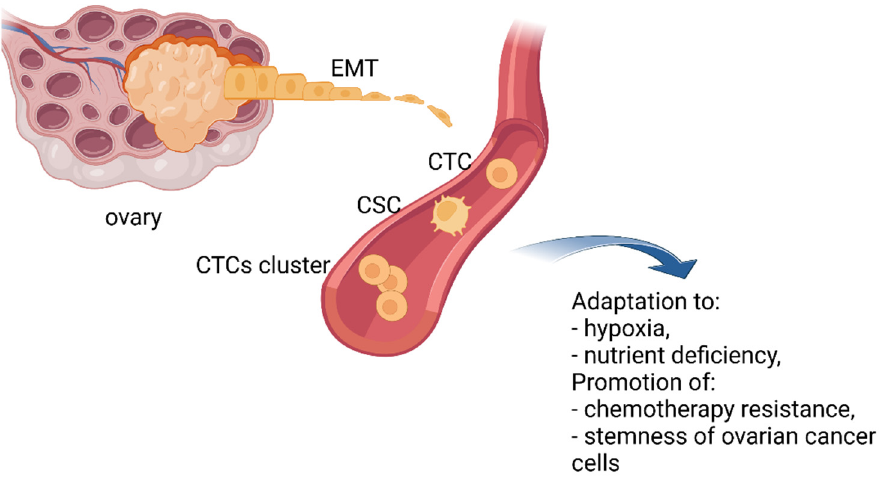
Figure 2. The ever-changing phenotype of CTCs. To increase their chances of survival, CTCs may change their phenotype from epithelial to mesenchymal, by clustering and/or acquiring cancer stem cell (CSC) properties. Created with https://biorender.com/, (accessed on 31 October 2022).